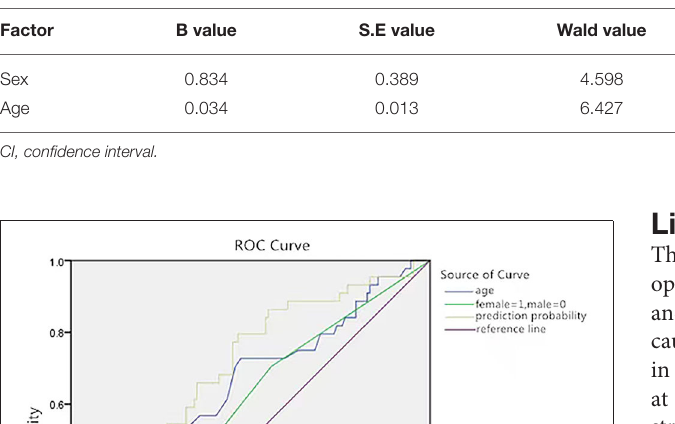
TABLE 4 | Determinants of syncope recurrence in the study population.